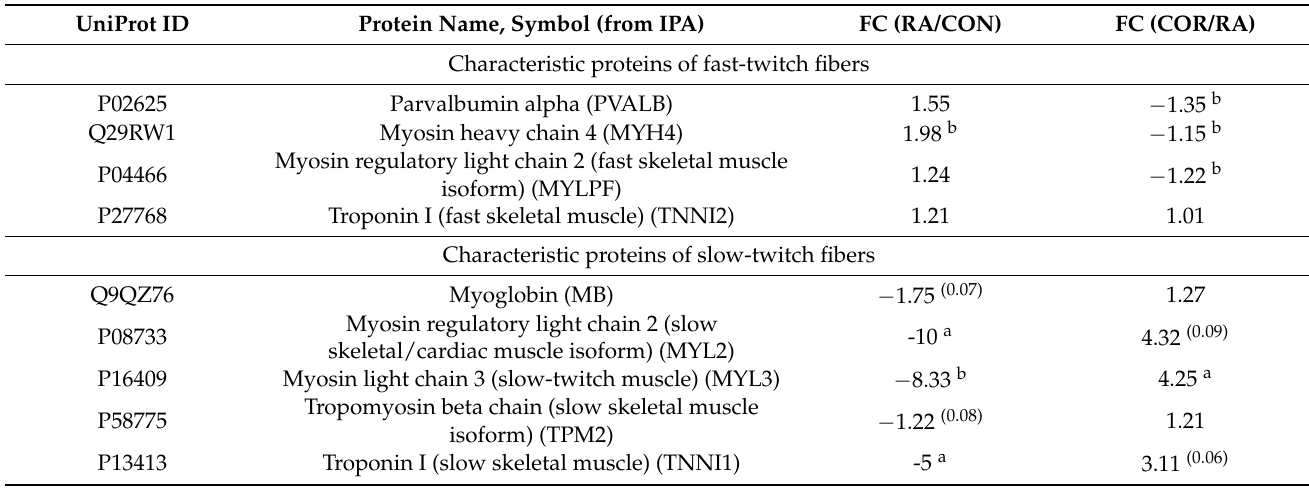
Table 1. List of DEPs/proteins related to